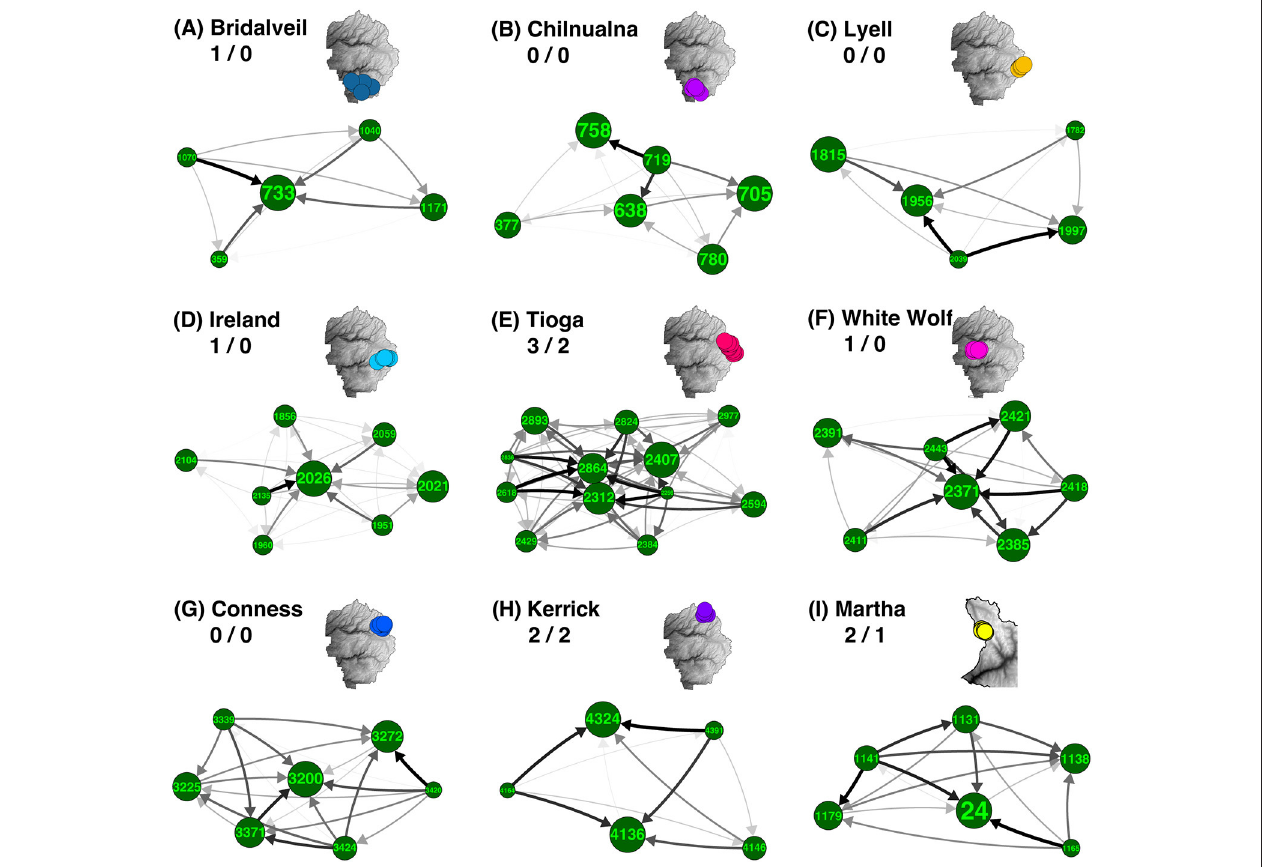
FIGURE 3 | Asymmetrical migration in meadow neighborhoods. Most of the meadow neighborhoods with five or more meadows are groups of closely related meadows with one or a few highly admixed “hubs” surrounded by more genetically distinct “satellites.” For each neighborhood, net asymmetry in migration rates (difference between emigration and immigration) is summarized by direction and shade of arrow. Meadow IDs and associated neighborhood names are labeled for all nine neighborhoods in YOSE and KICA that contain five or more meadows. Meadow node sizes are weighted by expected heterozygosity ( H E ; see Supplementary Table S1 ). Inset maps denote location of each meadow neighborhood (A–I) and have identical colors to Figure 1D . Numbers following neighborhood names indicate number of identified hubs/satellites (i.e., δ M more than one standard deviation from